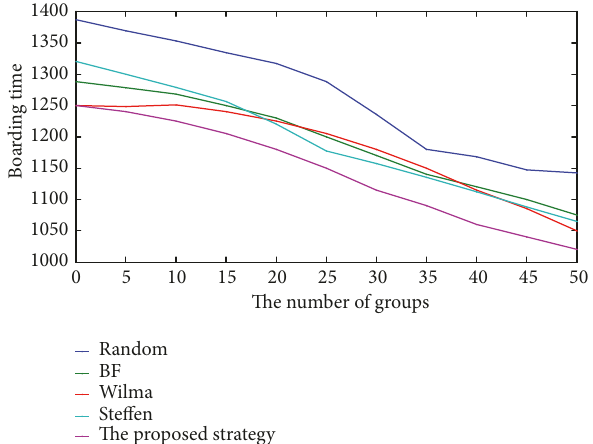
Figure 9: The total boarding time under the random, BF, Wilma, Steffen, and proposed